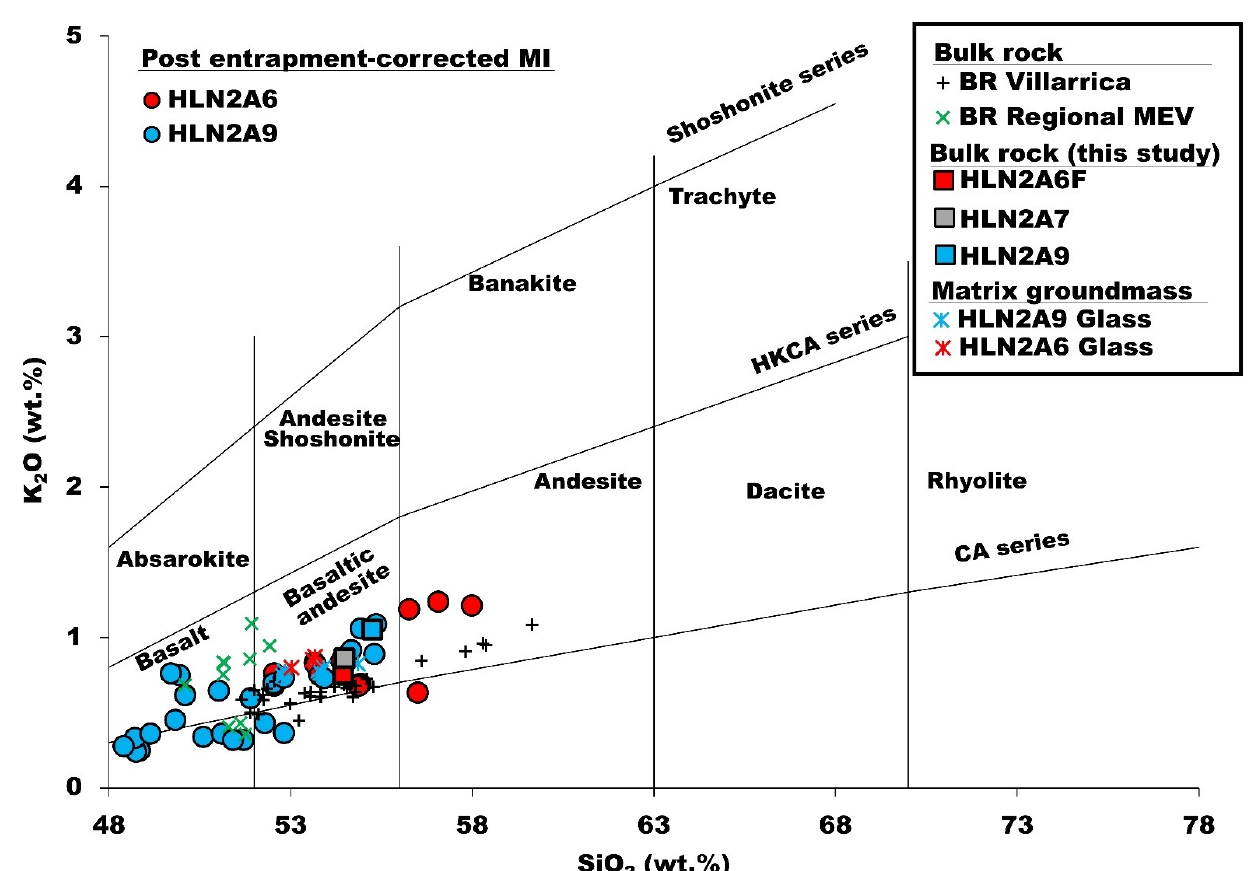
Figure 3. Major element composition of volcanic products from Los Nevados Subgroup 2. Post entrapment-corrected MI with their K 2 O-vs-SiO 2 classification. Basalt and basaltic andesite phenocrysts-hosted MI are shown as rounded shapes with red (HLN2A6) and blue (HLN2A9) filled color. Bulk rock samples from Los Nevados are represented by the colored squares. Repeated analyses involving international standard glasses resulted in errors of ≤ 1%. Literature data from Villarrica are represented by black cross, while MEV from regional sector close to Villarrica are illustrated with green X symbol (See references in Supplementary Material Figure S6).